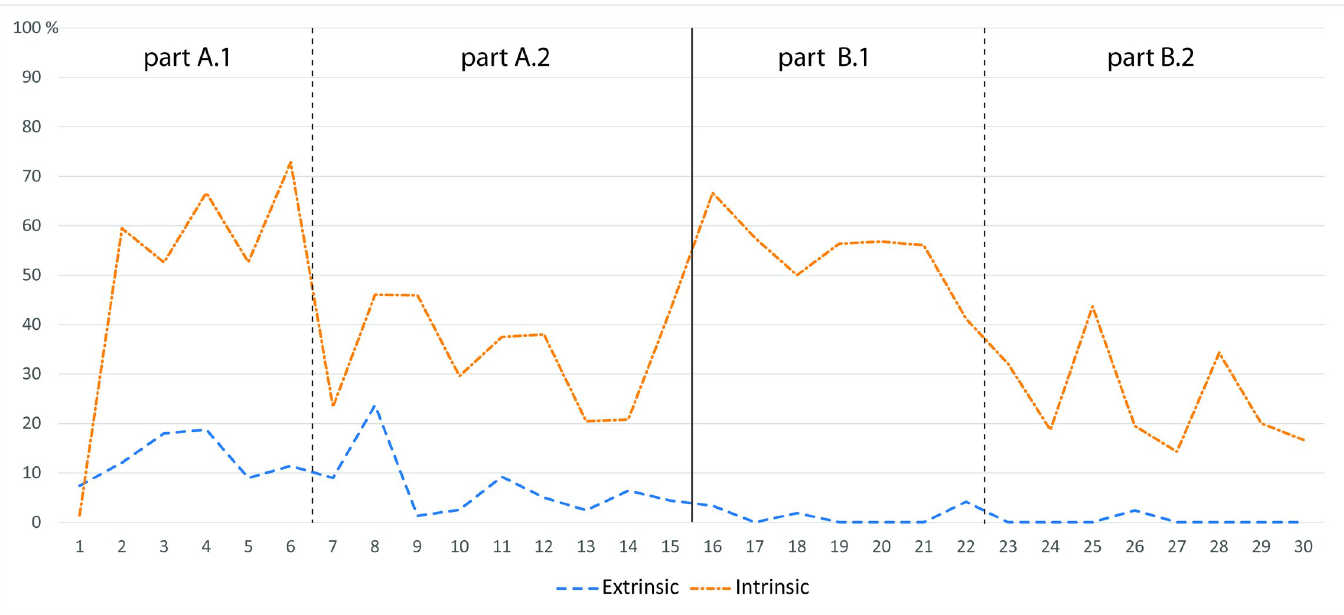
Fig 13. Ratio of the direct map-to-legend/legend-to-map saccades to the total number of direct saccades (%) between the defined AOI (instructions, legend, map, button